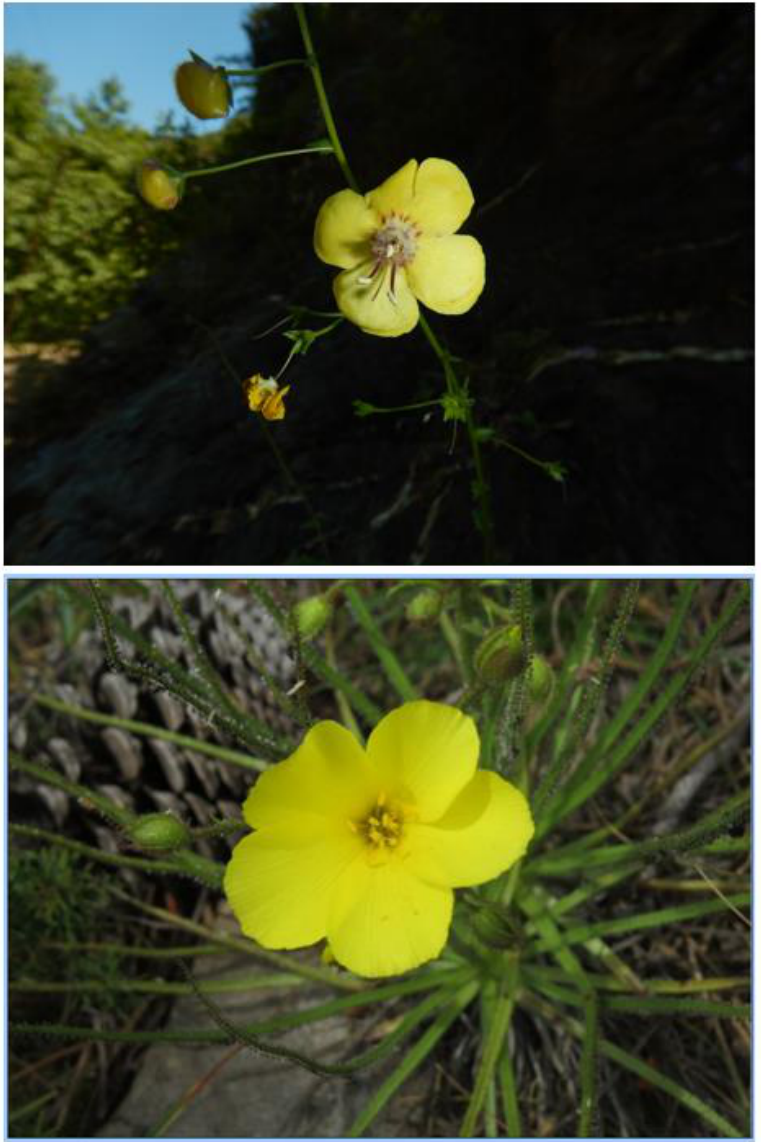
Figure 5. Top: Verbascum peraffine , an example of a Mediterranean local endemic confined to moun- tains and cliff faces on just two Greek islands (southern Evia and adjacent Andros Island to the south; photo S.D. Hopper). Bottom: Drosophyllum lusitanicum from southwest Spain, the only plant family endemic to the Mediterranean Floristic Region (photo John Vaclav).